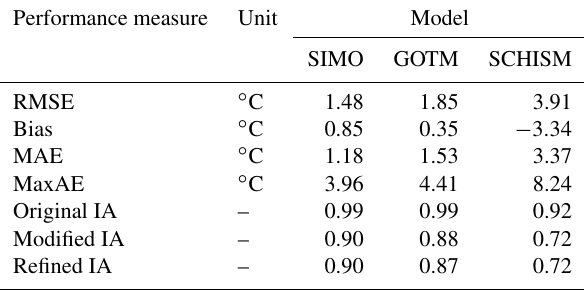
Table 3. Comparison of performance measures for SIMO, GOTM, and SCHISM for the period 1 January–27 December